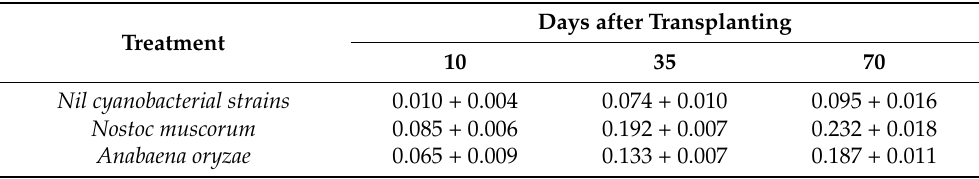
Table 2. Average total cyanobacterial count (10 4 cfu g − 1 dry soil) in the rhizosphere of rice plant at three periods after transplanting ± standard